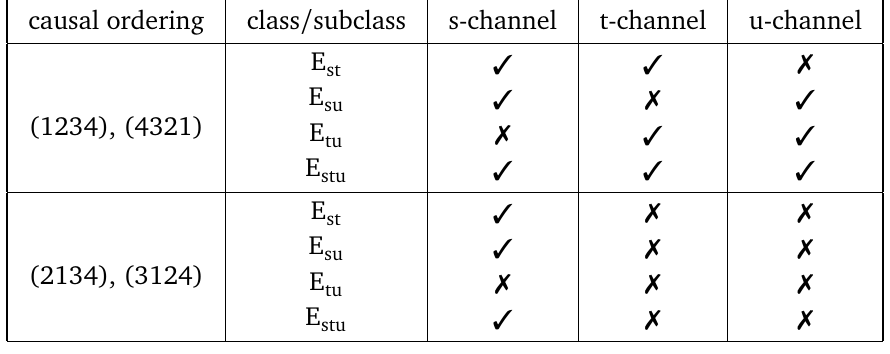
Table 9: OPE convergence properties of type 5 causal